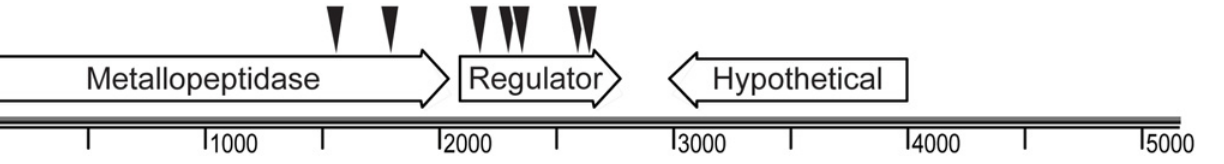
Fig 1. Open reading frame (ORF) map of the insert of metagenomic clone β LR16. Gray triangles designate the locations of transposon insertions that eliminated the resistance phenotype.